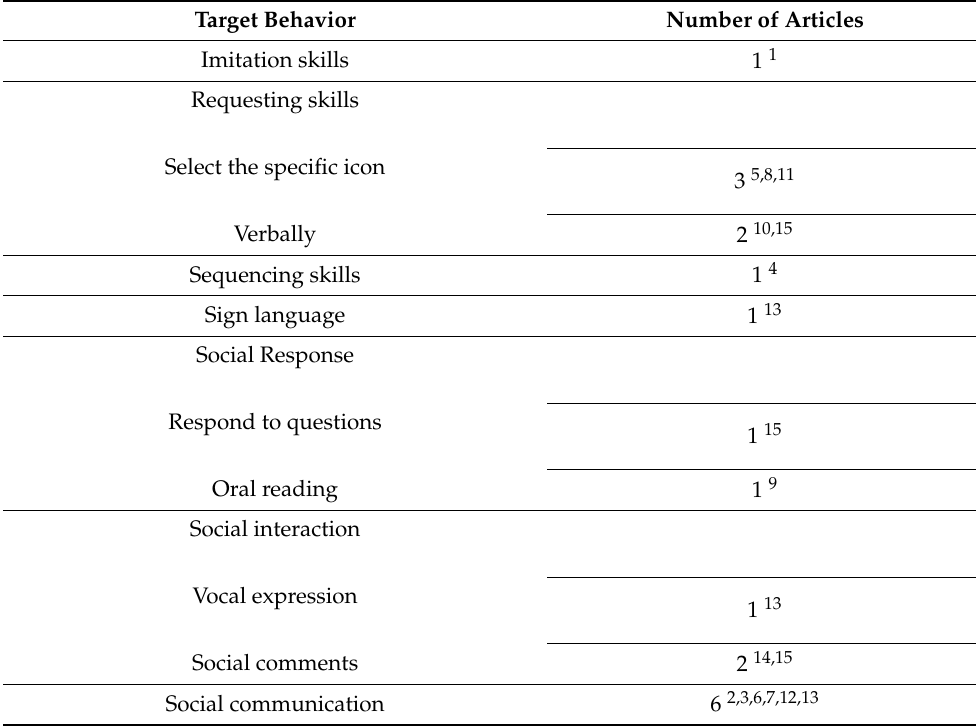
Table 3. Focus of